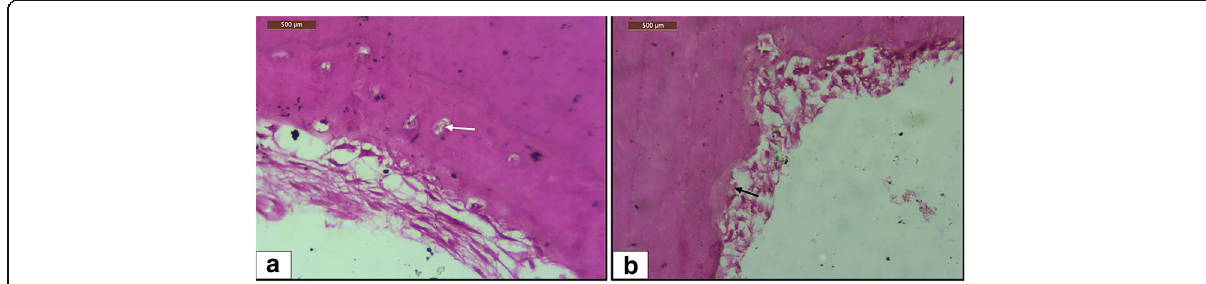
Fig. 6 Light microscope view of different types of cementum in the repair tissue. Magnification of ×40. a Craters showing repair with cellular cementum. Cementocytes are seen embedded in lacunae ( white arrow ) within the cemental matrix. b Craters showing repair with acellular cementum ( black arrow )